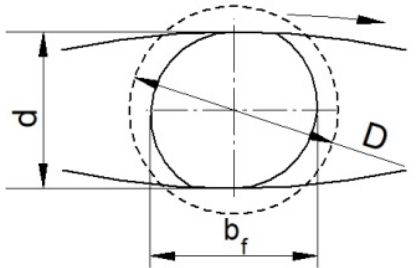
Figure 13. Scheme of the concave ‐ wedge CWR process with marked geometrical parameters.